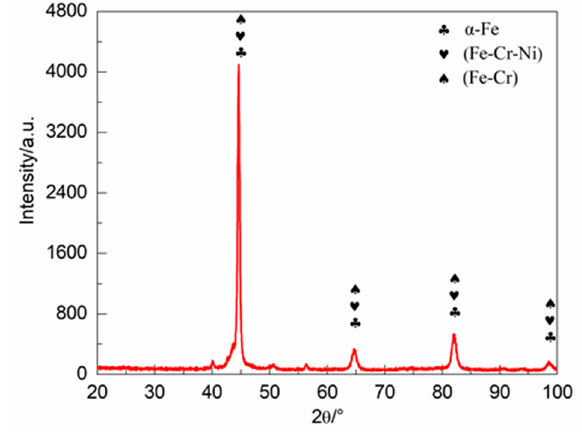
Figure 2. X-ray diffraction (XRD) pattern of Fe-based coating.